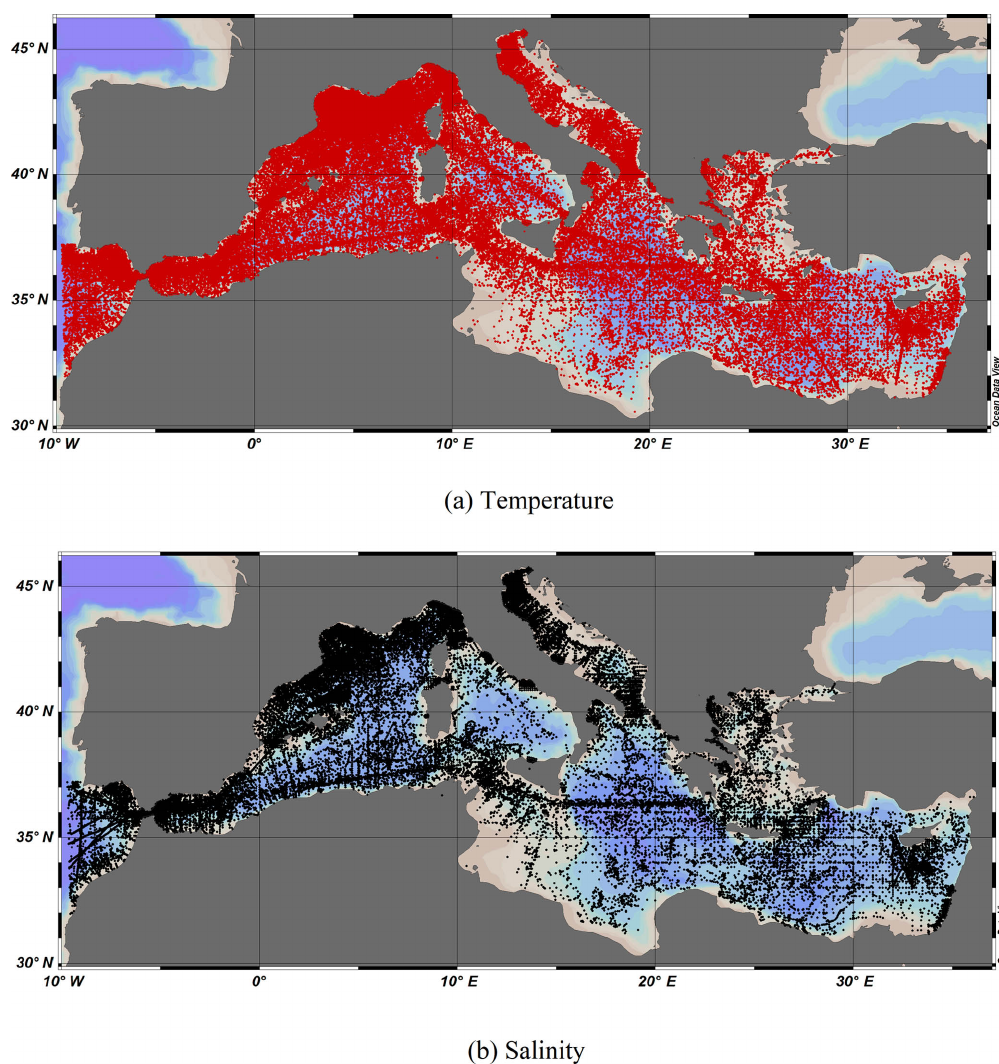
Figure 1. Geographical distribution of (a) temperature and (b) salinity profiles of the SeaDataNet V2 historical data collection (Simoncelli et al., 2015b, http://sextant.ifremer.fr/record/8c3bd19b-9687-429c-a232-48b10478581c/, last access: 9 July